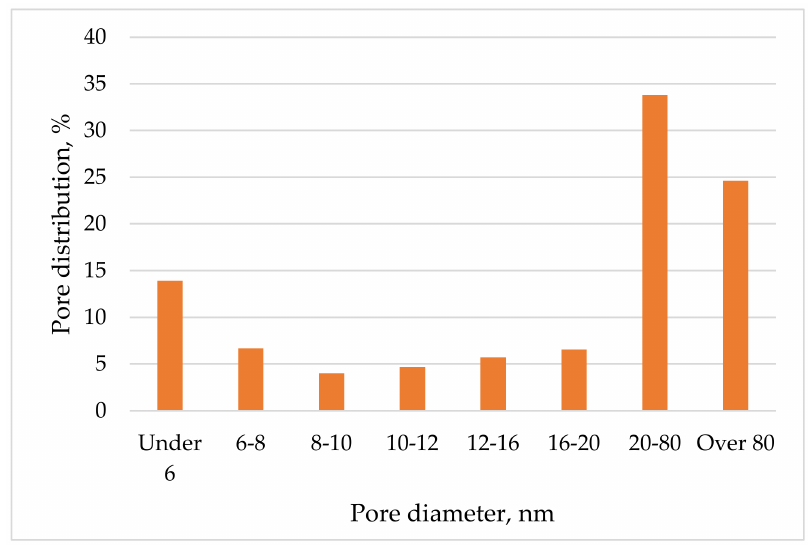
Figure 7. Pore distribution in the sample.